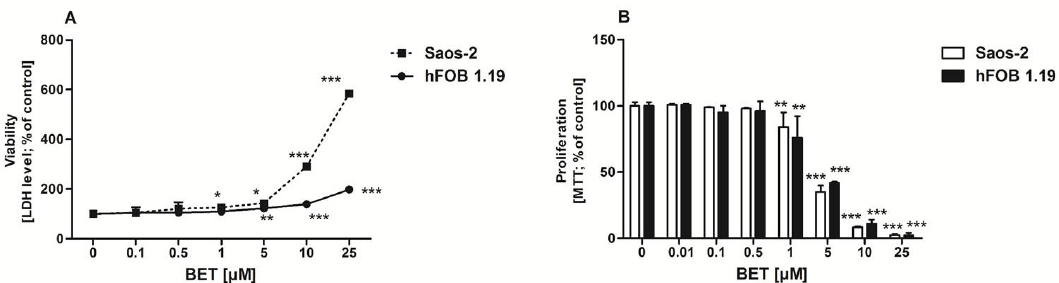
Figure 1. Effect of BET on hFOB 1.19 and Saos-2 cell viability ( A ) and proliferation ( B ). The osteoblasts were treated with the indicated concentrations of the compound and cell viability was estimated with the LDH assay after 24 h or cell proliferation was determined with the MTT method following the 96-h BET treatment. The results represent the mean ± SD of three independent experiments ( n = 24 per concentration), * p < 0.05, ** p < 0.01, *** p < 0.001 in comparison to the control, one-way ANOVA with post hoc Dunnett’s test.